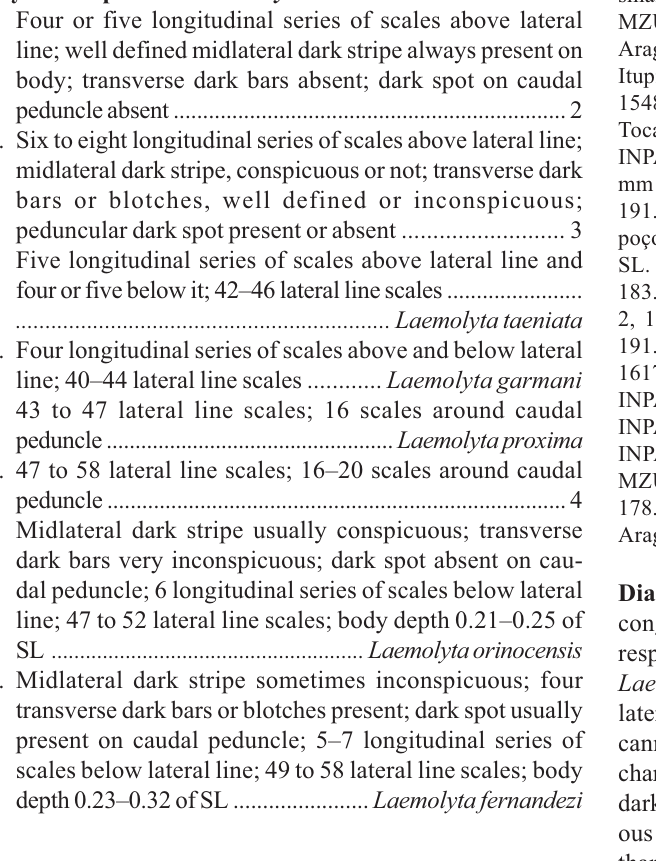
Table 1. Body moderately large (SL = 63.6–212.9 mm). Dorsal profile of body straight or slightly concave from snout tip to